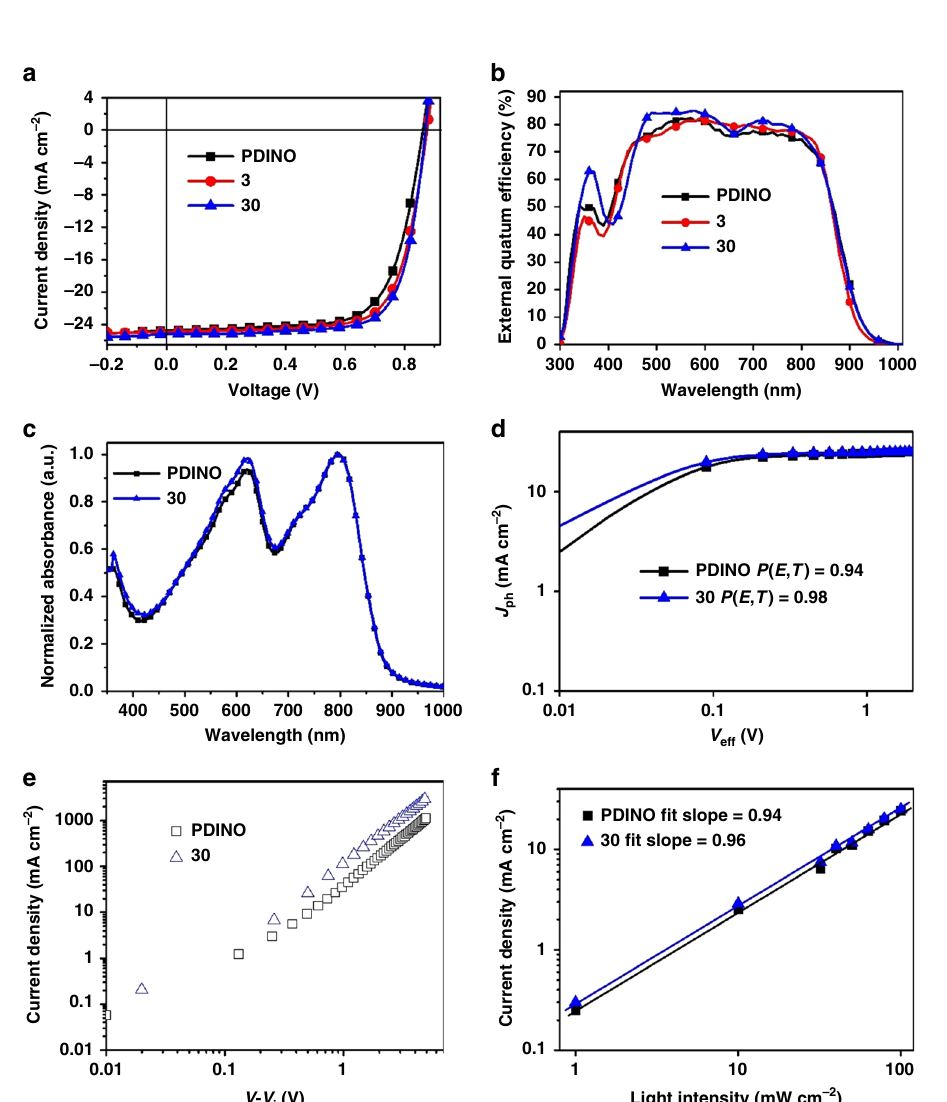
Fig. 7 The characteristics of organic solar cells devices. The ( a ) J – V and ( b ) EQE curves of OSCs based on PM6:Y6 with different ETLs respectively under 100 mWcm -2 AM 1.5 G irradiation. c The UV – Vis absorption spectra of blend fi lm PM6:Y6 ( d ) J ph – V eff curves. e J – V curves of electron-only devices. f J sc vs Light intensity curves based on PDINO and complex 30 ,